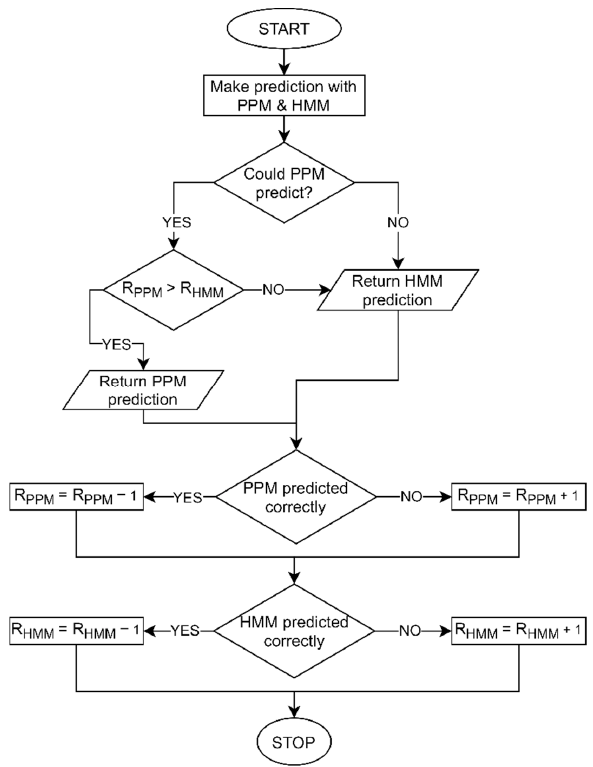
Figure 8. Hybrid predictor with reputation mechanism.